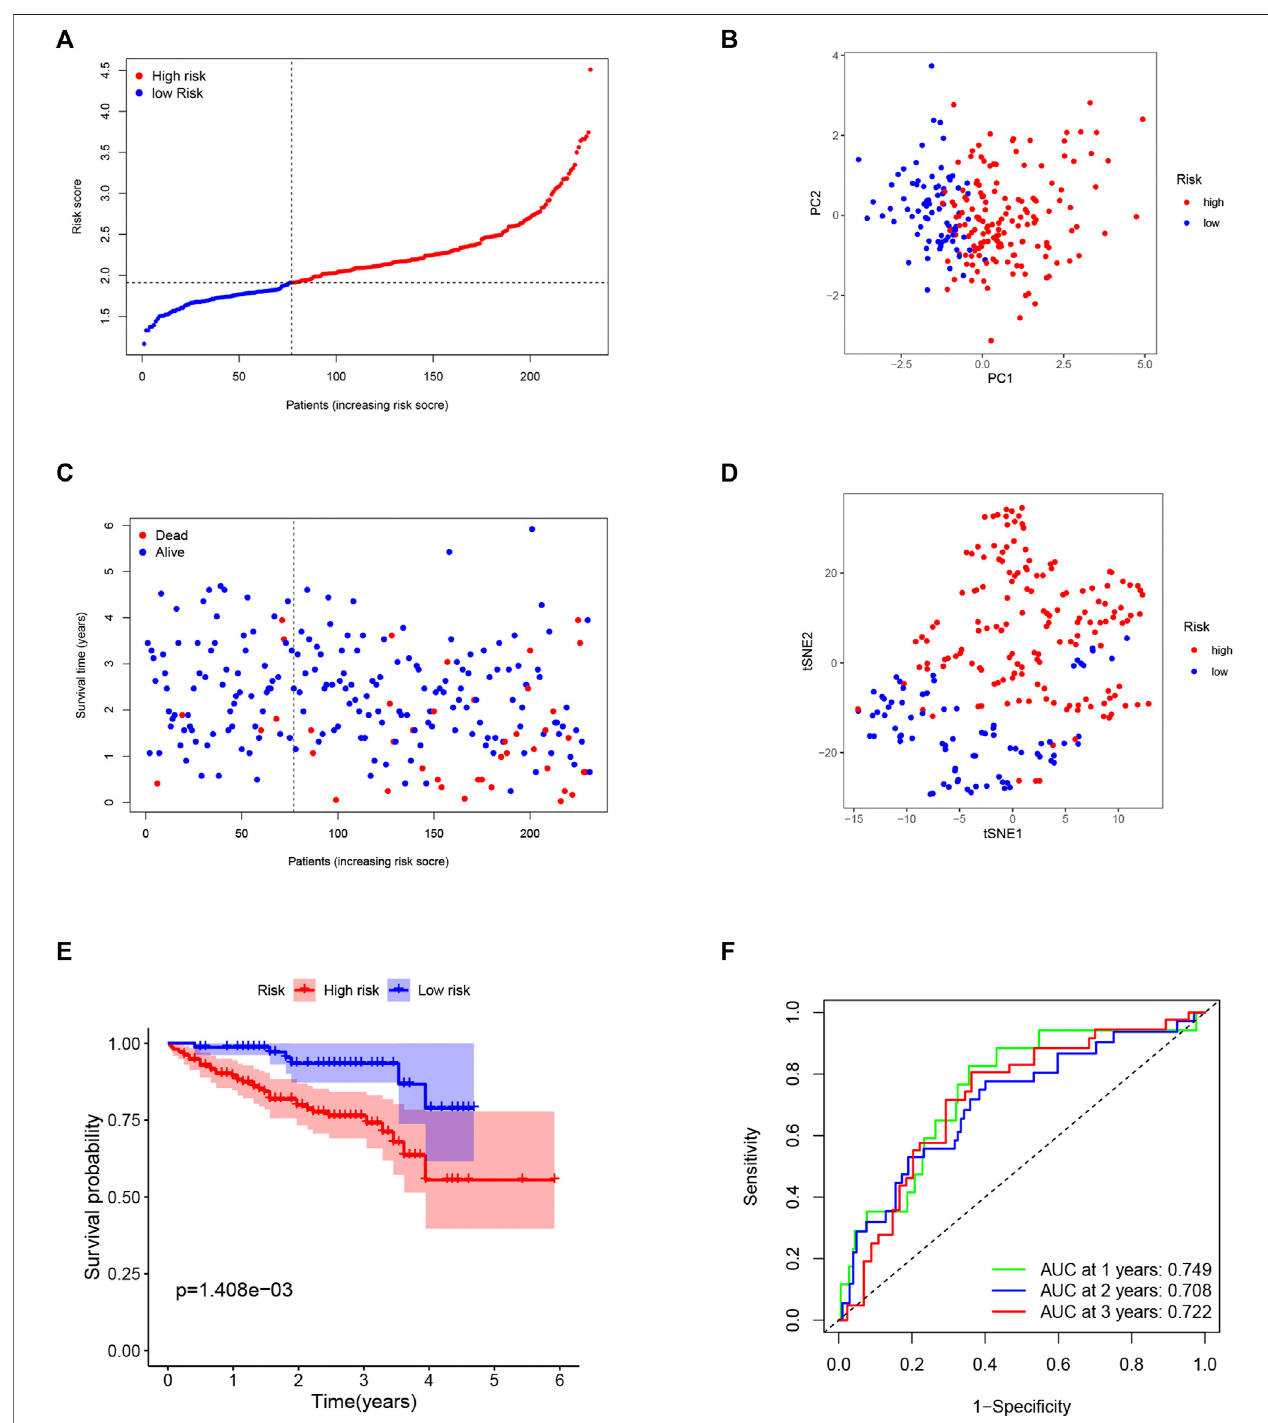
FIGURE4 | Validation ofthe 5-gene signature inthe ICGC cohort. (A) Thedistribution and median value oftherisk scores inthe ICGC cohort. (B) The distributions ofoverallsurvival(OS)status. (C) PCAplotoftheICGCcohort. (D) t-SNEanalysisoftheICGCcohort. (E) Kaplan – MeiercurvesfortheOSofpatientsinthehigh-andlow- risk groups. (F) . ROC curves in the ICGC cohort.